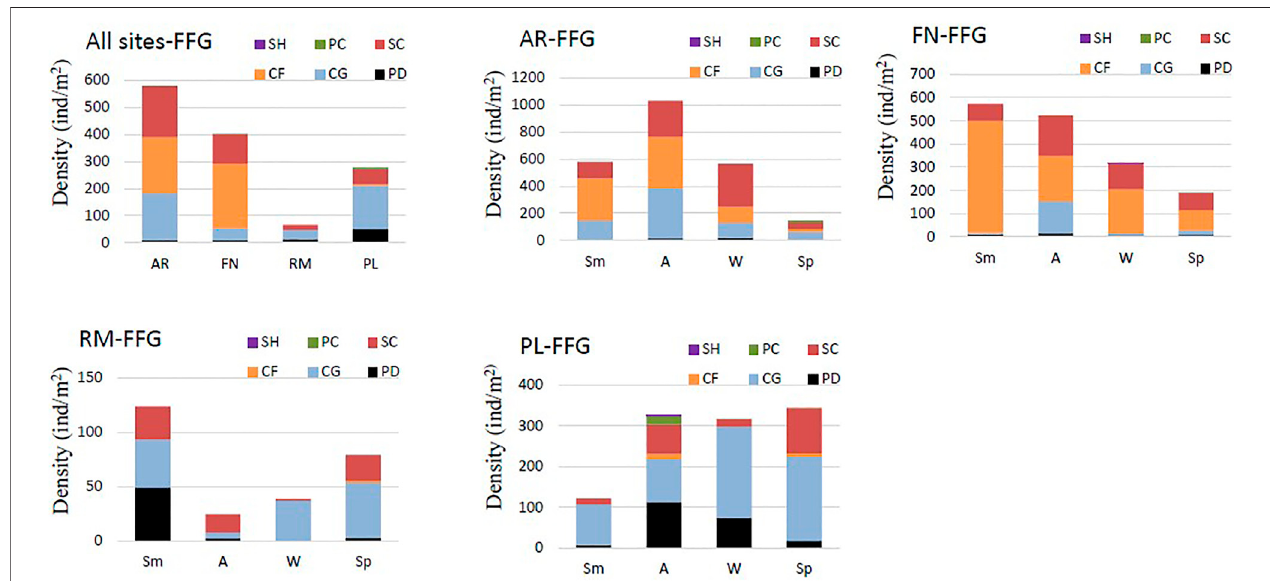
FIGURE 5 | Density of functional feeding groups (FFG) of macroinvertebrates in all sites (mean) and in river (AR, Arroyito; FN, Fortín Nogueira) and reservoir (RM, Ezequiel Ramos Mexía; PL, Pichi Picún Leufú) sites of Limay River, Patagonia, SH, shredders; SC, scrapers; CF, collector- fi lterers; CG, collector-gatherers; PD, predators; PC, piercers; Sm, summer; A, autumn; W, winter and Sp,